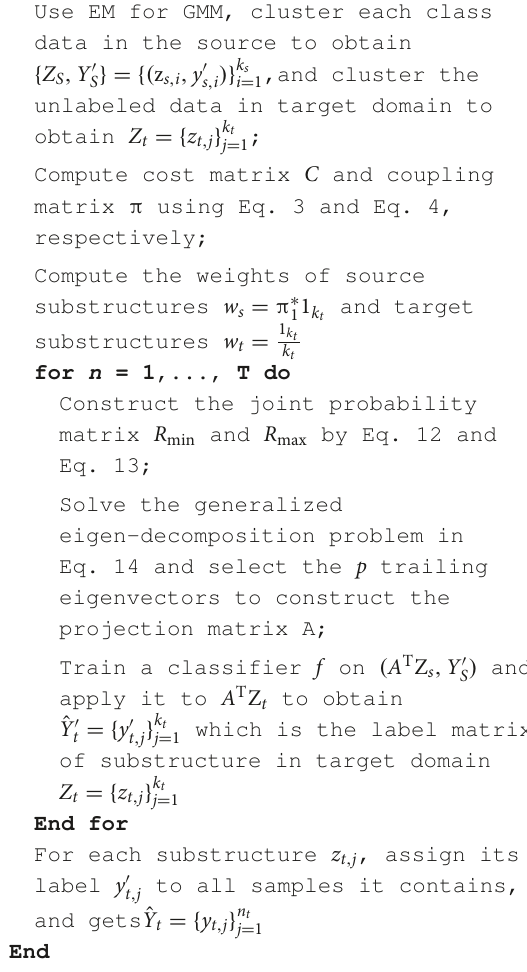
Algorithm 1. Substructural Joint Probability Distribution Adaptation